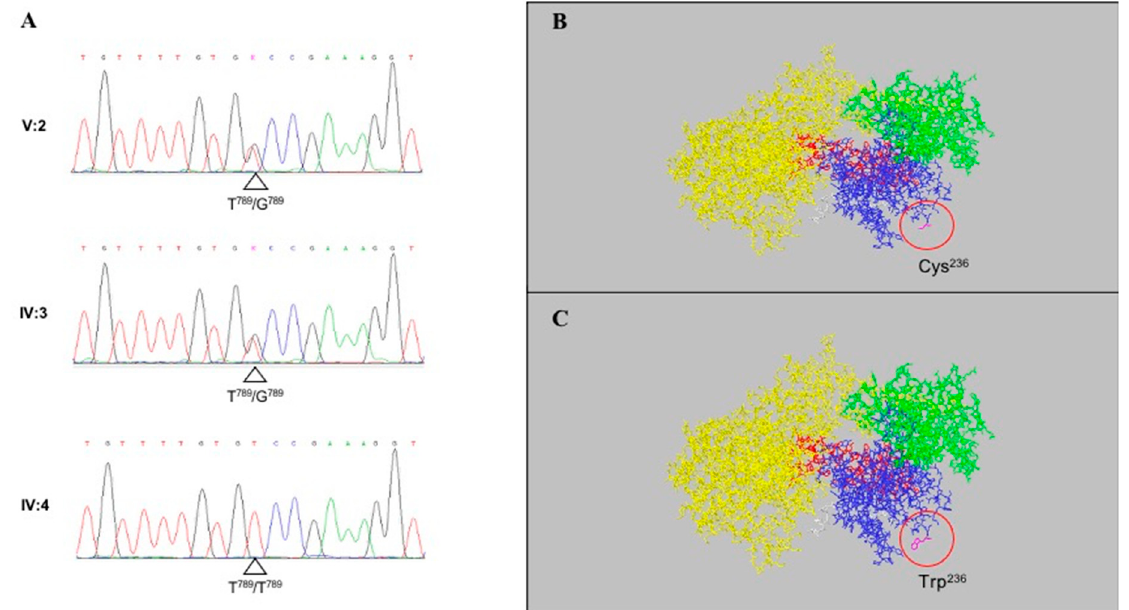
Figure 1. Panel ( A ) sequencing data showing the T-to-G missense mutation in exon 8 (c.789T > G). Panels ( B , C ) 3D model of the native (panel ( B )) and mutated (panel ( C )) γ S complexes. Nicastrin protein is presented in yellow, PSEN1 in blue, the APH-1A subunit in green, PSEN2 in red, the poly-Ala chain in grey, and the aminoacid 263 in violet. We also sequenced the PSEN1 gene in one healthy control (proband’s father; IV:4) and the missense mutation was not present.